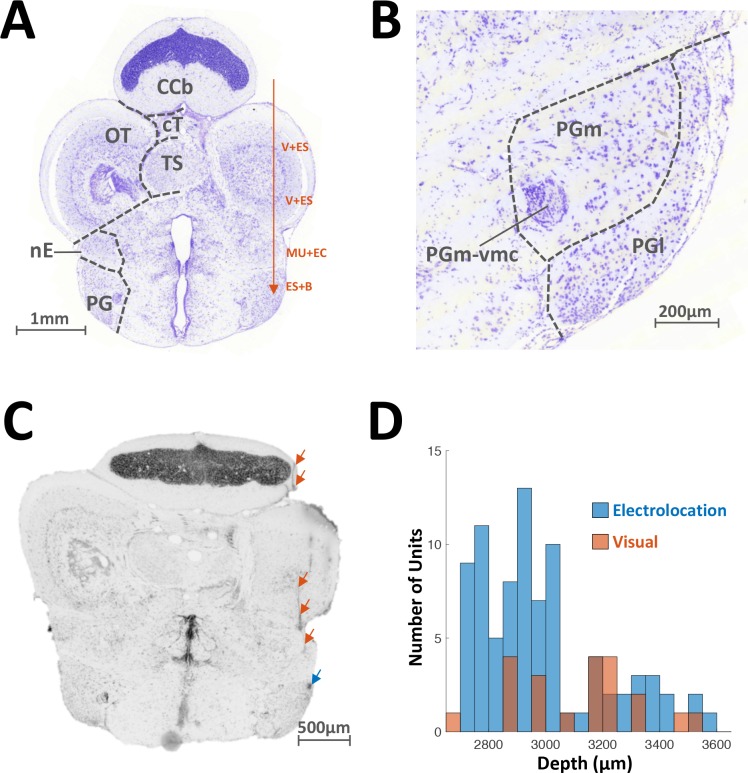
Localization of recorded units.(A) Transverse slice of the brain of A. Leptorhynchus, about 300 μm caudal to the midbrain-telencephalon boundary (around electric fish atlas level T24, Maler et al., 1991). Electrodes were inserted 800–1000 μm lateral to midline and advanced ventrally (red arrow). Visual and electrosensory stimuli were presented as the electrode was lowered in order to identify PG. There was variation in the depth of the various responses encountered depending on the size and precise orientation of the fish. Typically, visual and electrosensory (V + ES) responses were encountered around 1200 μm and 1900 μm ventrally to the top of the corpus cerebellum (CCb), as the electrode passed through the rostral edge of the optic tectum (Bastian, 1982). Further down, weak multi-unit activity responding to electro-communication signals (MU + EC) was usually detected around 2300–2500 μm, as the electrode passed through n. electrosensorius (nE, Heiligenberg et al., 1991). Finally, preglomerular (PG) responses were predominantly electrosensory and were characterized by bursting (ES + B, see Figure 1B–C). TS: Torus Semicircularis; cT: tectal commissure. (B) Close-up image of panel (A) showing the lateral (PGl) and medial (PGm) subdivisions of PG. PGm-vmc: ventromedial cell group of PGm. (C) Transverse slice prepared after recording motion-sensitive PG cells. The electrode track is visible through the edge of the cerebellum, the bottom of OT and nE (red arrows). The electrode tip mark is visible in PGl (blue arrow). (D) Distribution of depths (relative to top of cerebellum) where electrosensory motion-responsive (blue) and visual-responsive (red) single-units were recorded from. The visual units were usually in the more ventral portion of PG. We note that the recording depths correspond to the anatomical definition of PG and encompass its full extent (Maler et al., 1991).